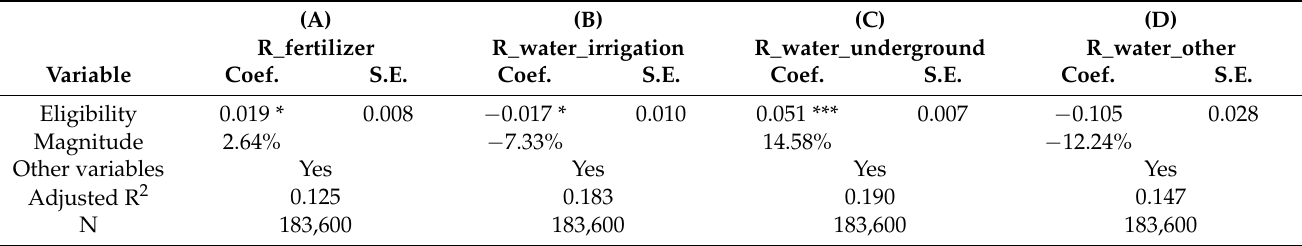
Table 3. Estimation results for production inputs relevant to the